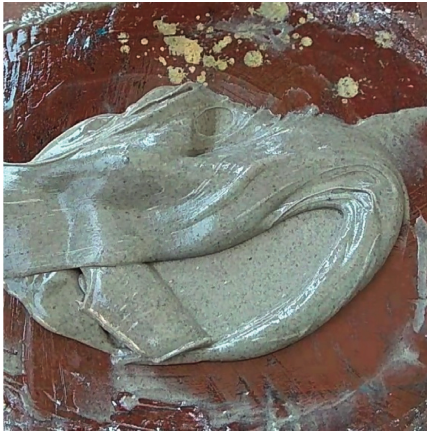
Figure 7: Mixture of epoxy resin, quartz powder, and rice husk ash.